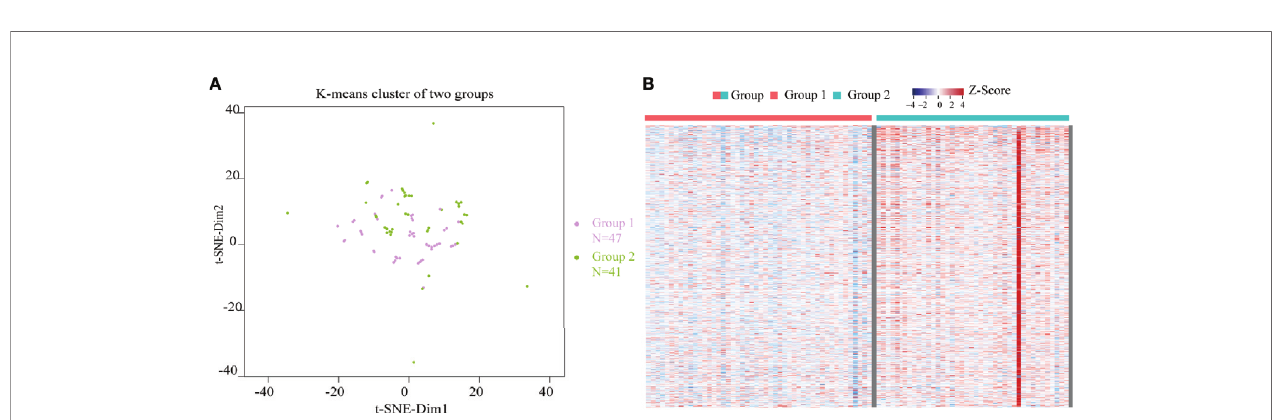
FIGURE 3 | Clustering of READ samples and heatmap of the expression of m 6 A candidate genes between two subgroups. (A) K-means clustering graphs of group 1 and group 2. (B) The expression heatmap of the 974 m 6 A candidate genes in READ between two subgroups. Row represents a gene while column represents a patient sample. The samples were sorted from left to right with group 1 indicated in red and group 2 in blue. Genes were sequenced from small to large top-down according to the P value from the differential expression analysis results. Red represents high expression, purple represents low